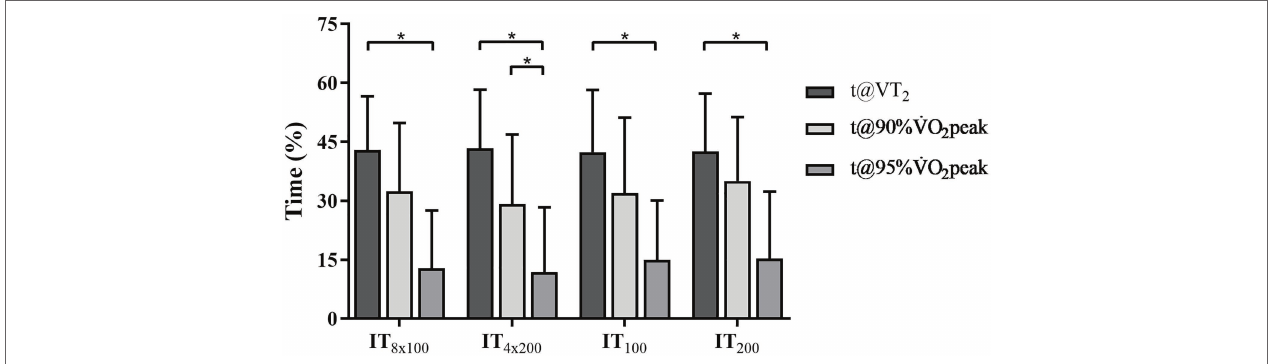
FIGURE 4 | The percentage of t@VT 2 , t@90% ⩒O 2 peak, and t@95% ⩒O 2 peak at IT 8x100 , IT 4x200 , IT 100 , and IT 200 . *Statistical difference intra interval training (IT) protocols (t@VT 2 vs. t@90% ⩒O 2 peak vs. t@95% ⩒O 2 peak) at p ≤ 0.05. No differences were observed between the IT protocols (IT 8x100 vs. IT 4x200 or IT 100 vs. IT 200 ).